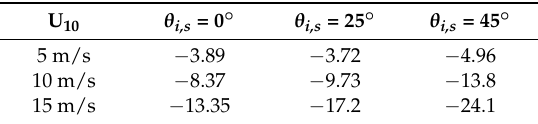
Table 2. Average EM bias β [cm] for incidence/scattering angles θ i = θ s = 0 ◦ , 25 ◦ and 45 ◦ , for EM